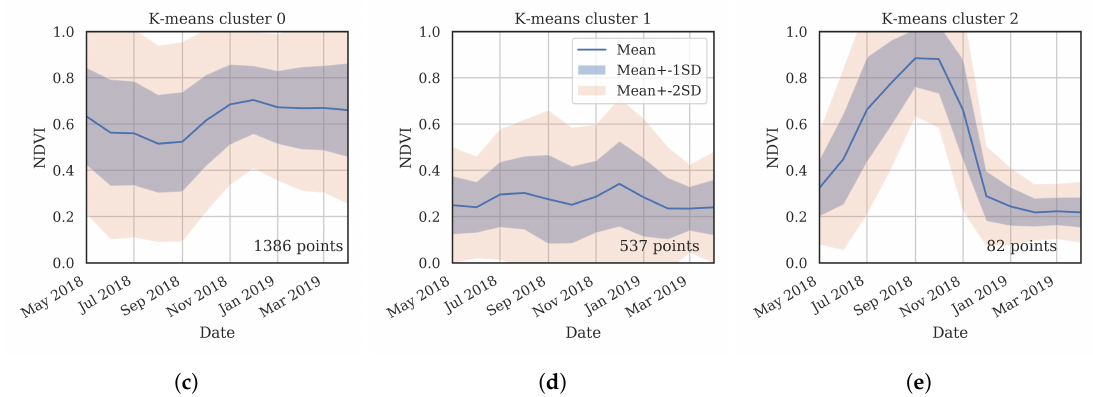
Figure 10. Analysis of K-means (k = 3) clustering of training points. ( a ) shows the number of training points per class and per cluster. ( b ) shows the maximum NDVI for each training point per cluster, with classes grouped into Perennial, Annual and Other. ( c – e ) show the time-series for training points from each cluster, including the mean and 1 and 2 standard deviations from the mean.